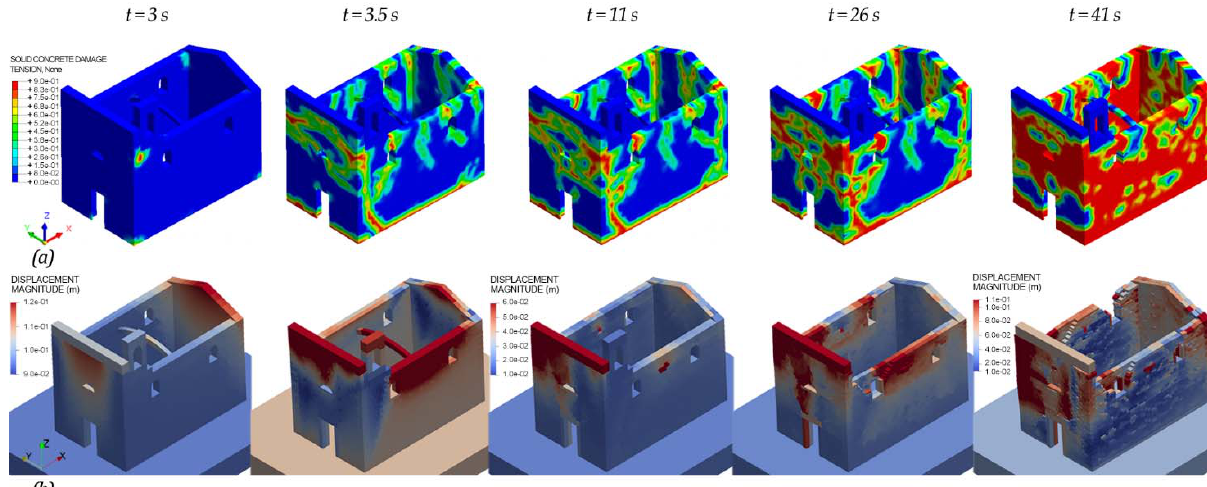
Figure 16. Views of the evolution of ( a ) tensile damage in the CDP model and ( b ) displacement in the NSCD method at different time instants of the nonlinear dynamic analyses performed under the epicentral seismic actions.